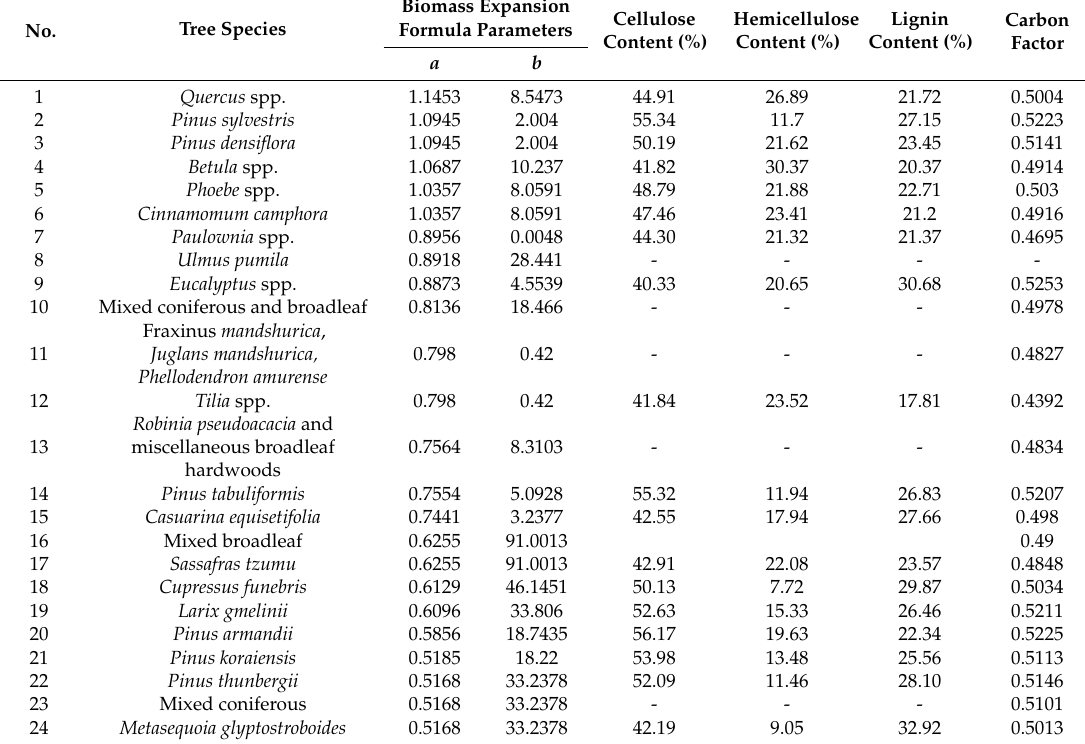
Table 1. Biomass expansion formula parameters and carbon factors for the principal tree species in China’s arboreal